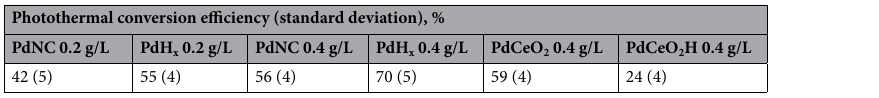
Table 3. Photothermal conversion efficiencies of nanofluids of Pd, PdCeO 2 and their hydrogenated forms with the laser power of 439 mW. Numbers inside parentheses are the standard deviations of the efficiencies.